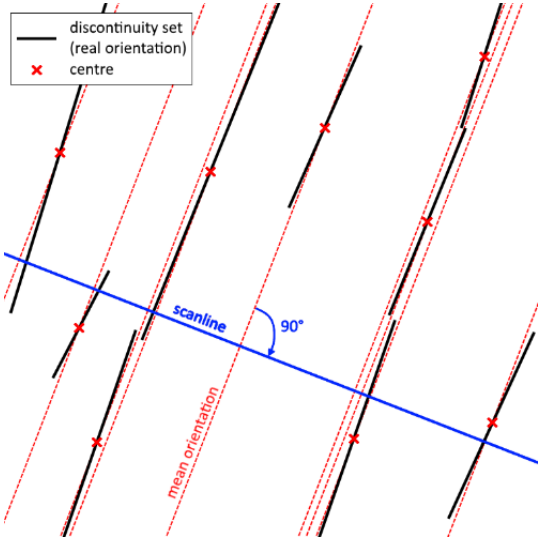
Figure 2. Virtual scanline, normal to the mean family set orientation